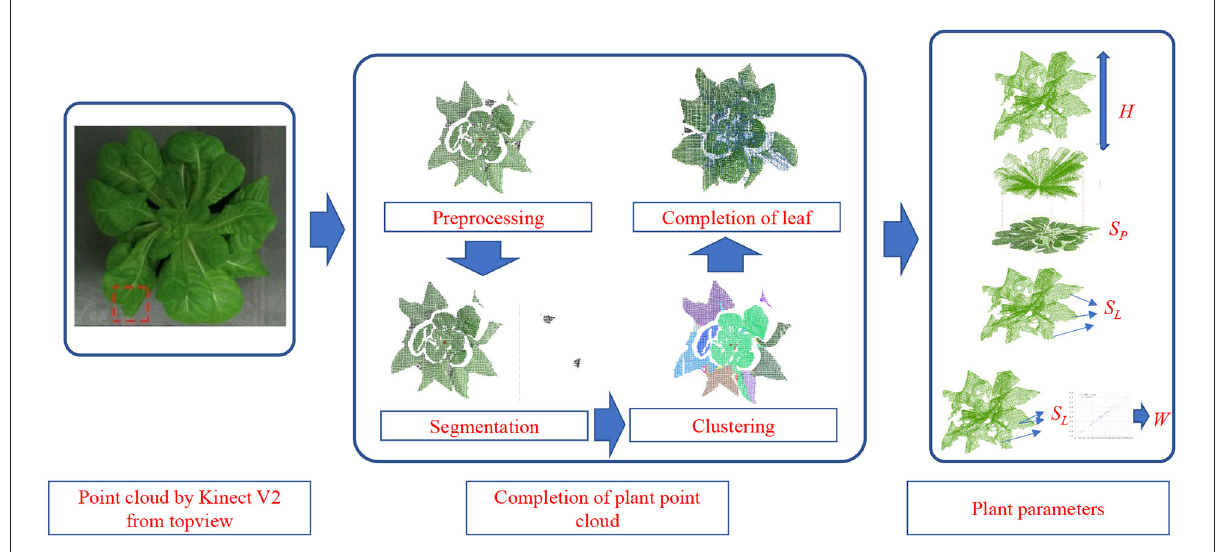
FIGURE1 The workflow of the completion of plant point cloud and the acquisition of plant growth parameters.